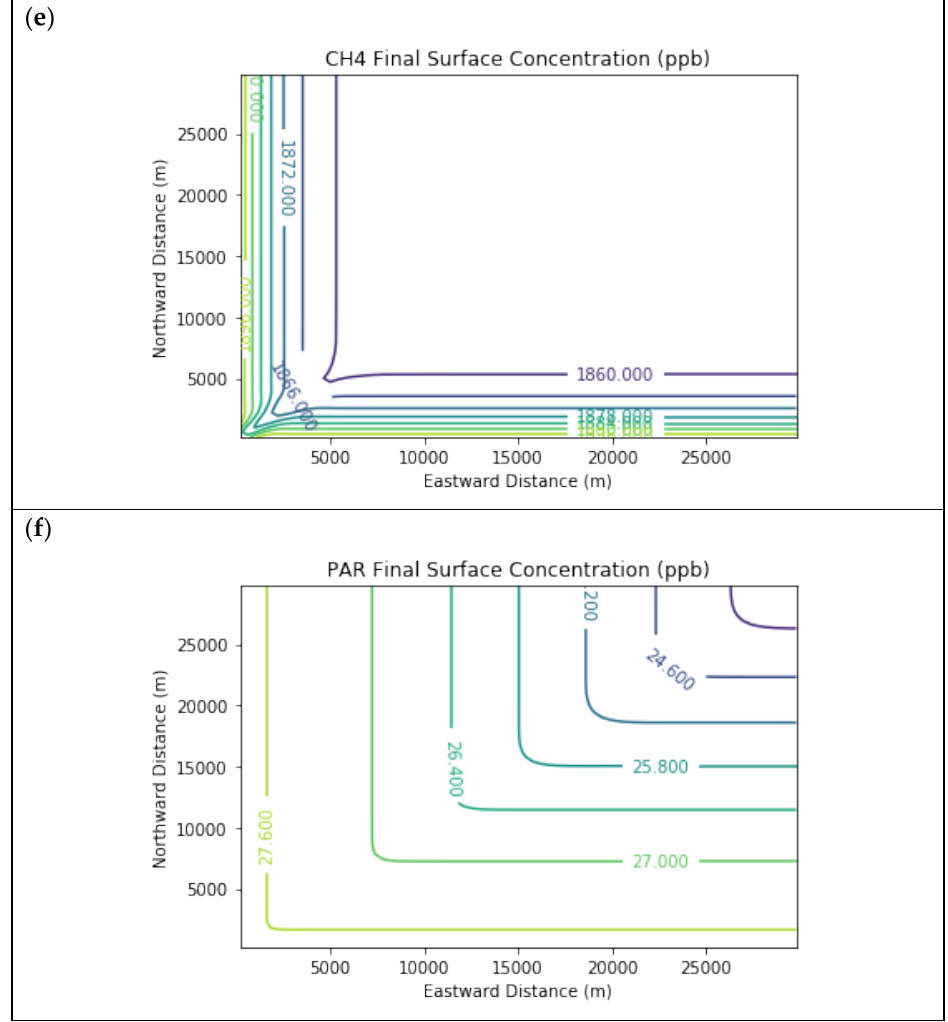
Figure 6. Near Source: Fugitives + Combustion − Combustion Only. Final surface concentrations of ( a ) NO, ( b ) NO 2 , ( c ) O 3 , ( d ) HCHO, ( e ) CH 4 , and ( f ) PAR at the end of the 3-h simulation in the Baseline scenario for the 30 km × 30 km domain.